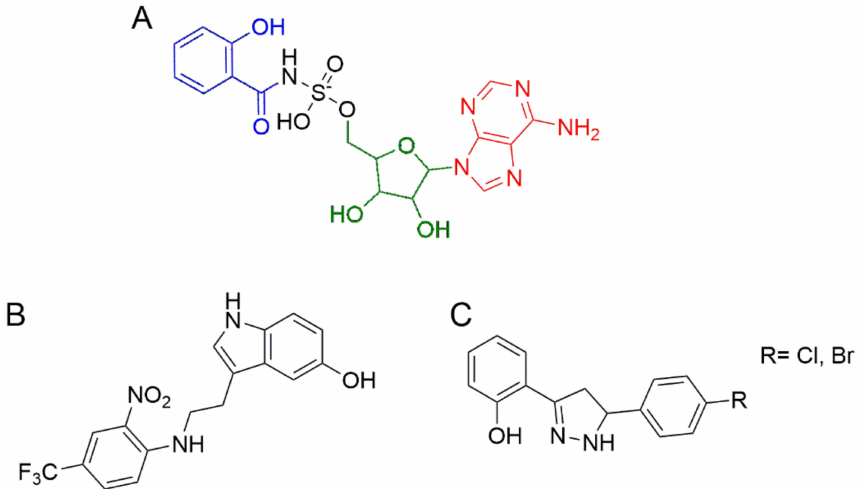
Figure 5. Chemical structures of MbtA inhibitors with antitubercular activity: ( A ) 5 (cid:48) -O-N- salicylsulfamoyl adenosine, with the salicylate moiety in blue, the sugar in green, and the nucleobase in red; ( B ) 5-hydroxy-indol-3-ethylamino-(2-nitro-4-trifluoromethyl)benzene obtained by whole-cell screening, combined with a target-based approach; ( C ) 3-(2-hydroxyphenyl)-5-(aryl)-pyrazolines derived from the mycobactin structure by rational